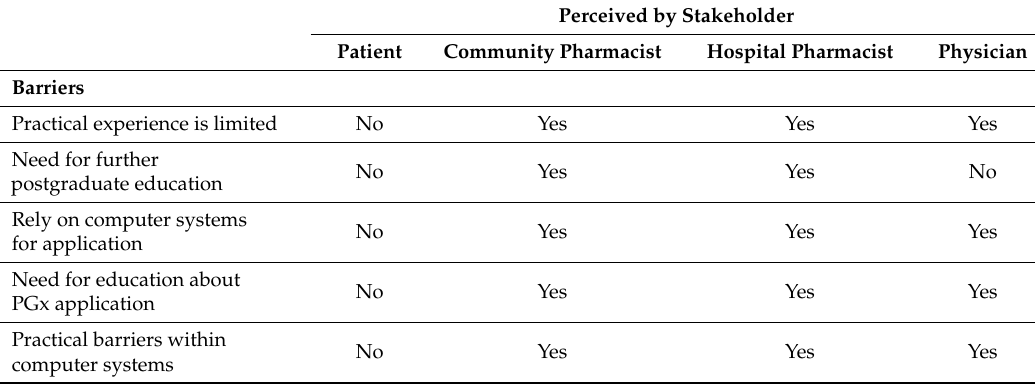
Table 3. Barriers and facilitators to pharmacogenomic screening